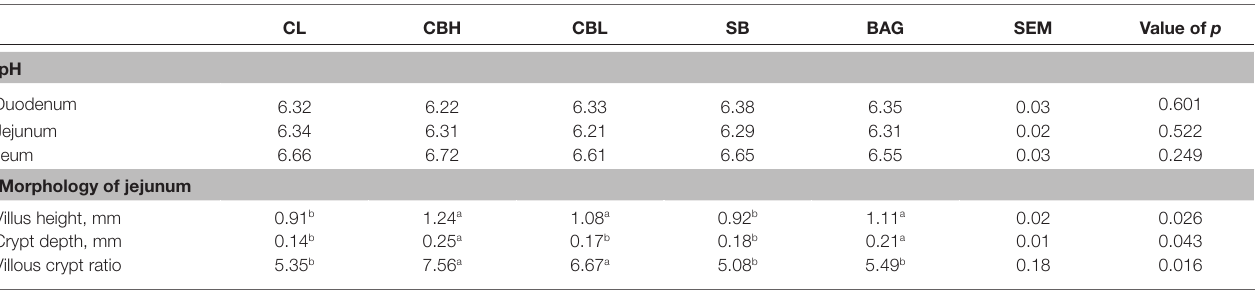
TABLE 6 | Intestinal pH and morphology of yellow-feathered breeder hens. CL CBH CBL SB BAG